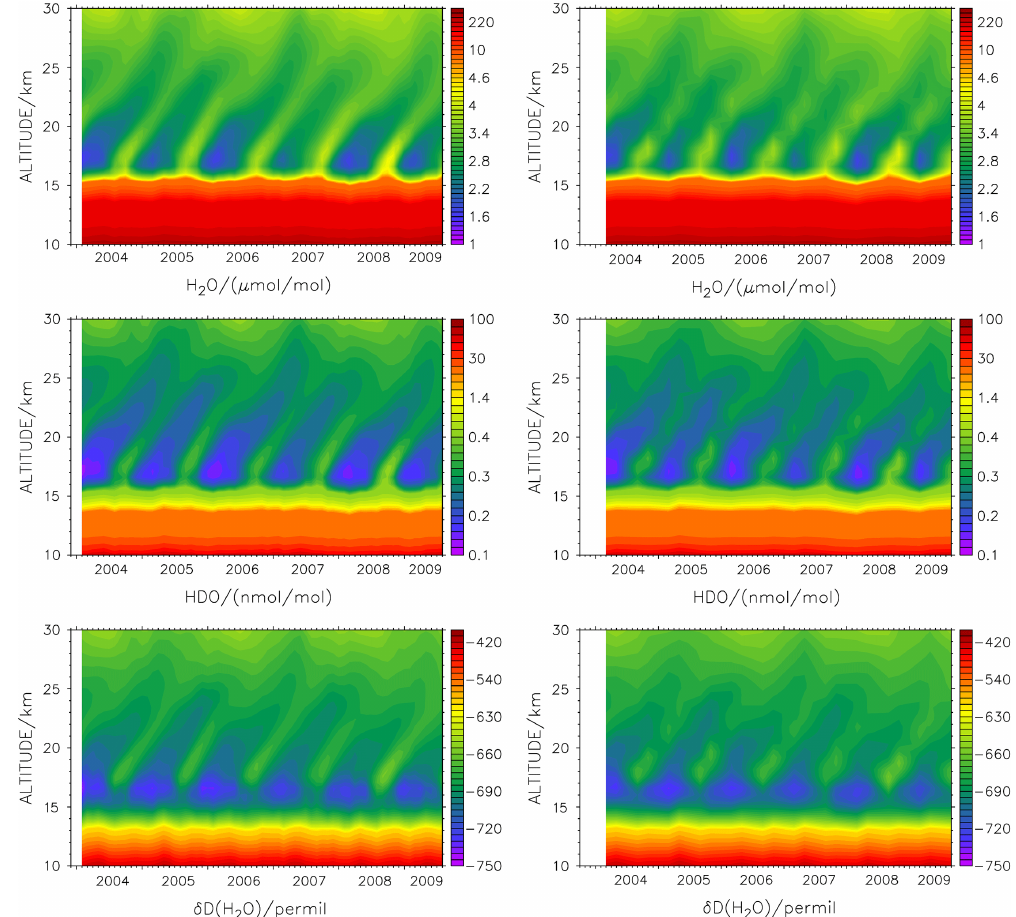
Figure 7. Altitude–time diagrams of H 2 O, HDO and δ D(H 2 O) in the Tropics (15 ◦ S–15 ◦ N) from the EMAC simulation. Left: monthly averages; right: averages of only February, April, August and October, as in Randel et al. (2012). The plotting algorithm linearly interpolates between the available